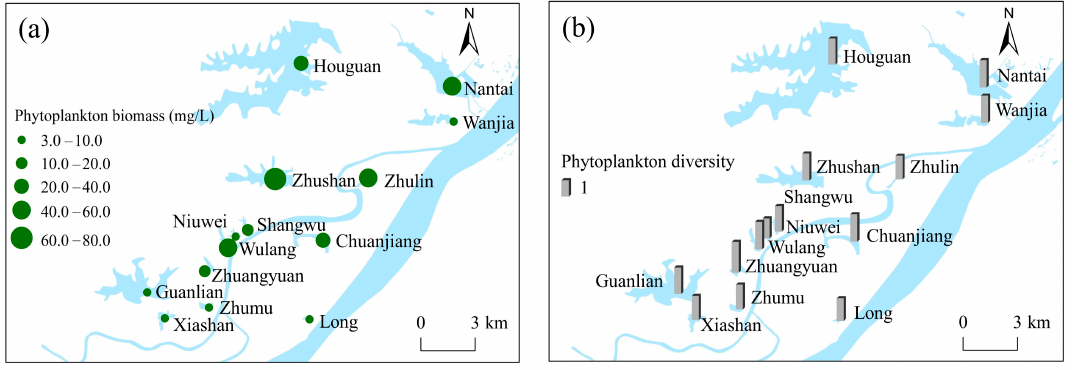
Figure 2. Phytoplankton biomass and diversity in analyzed urban lakes. ( a ) Phytoplankton biomass; ( b ) Phytoplankton diversity.